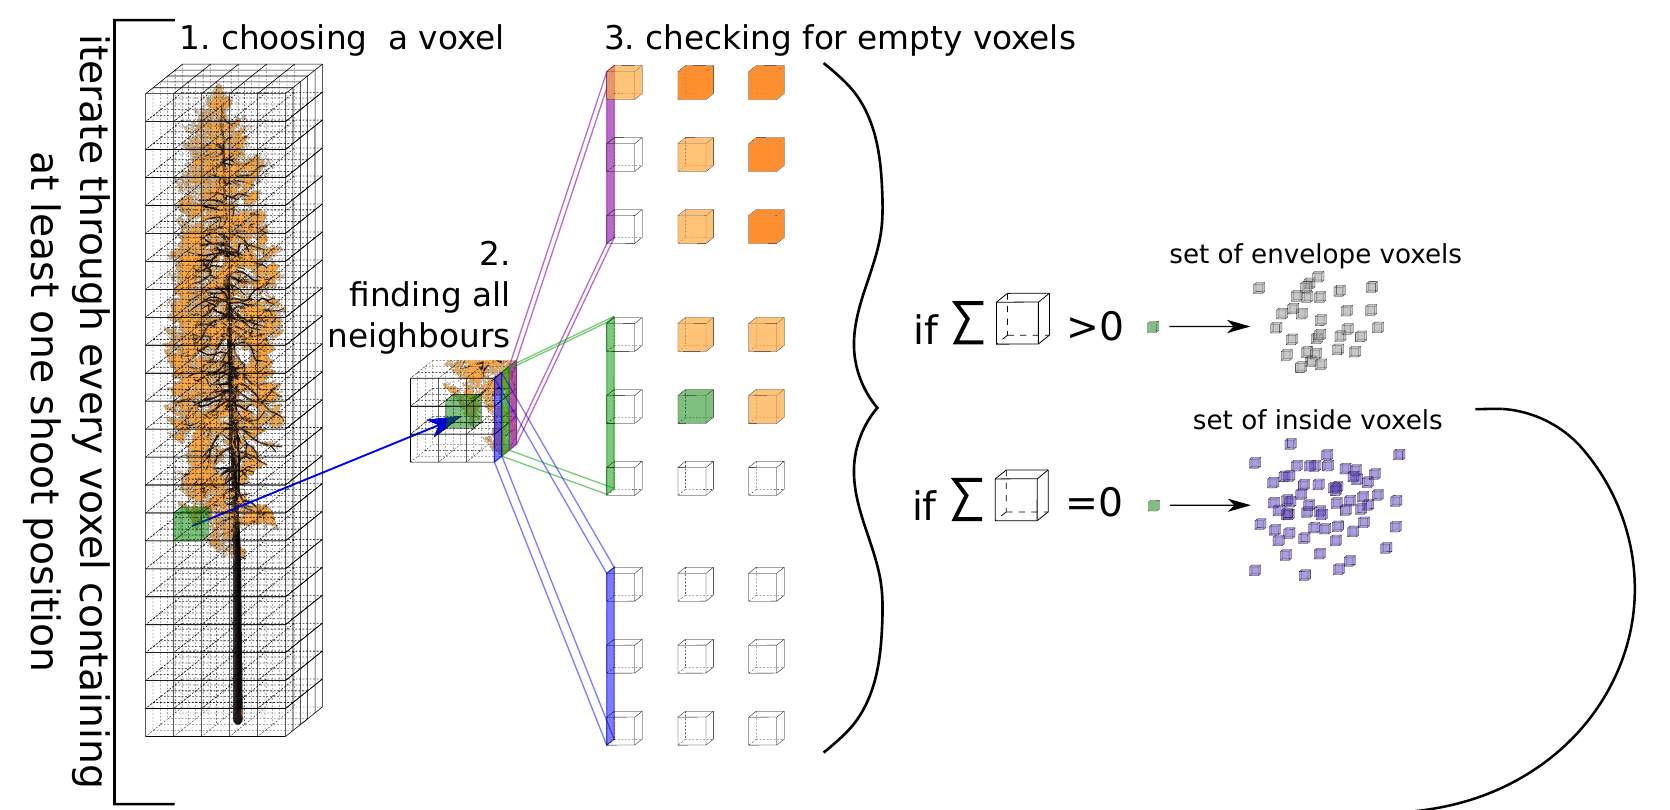
Figure A1. The process of finding crown envelope. The corresponding steps are described above 1.–